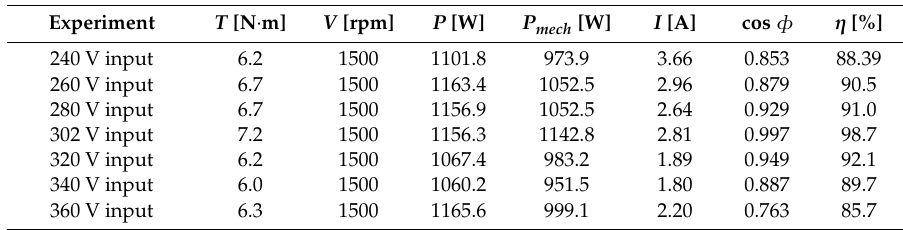
Table 1. PMSM e ffi ciency determination Table 1. PMSM efficiency determination results.